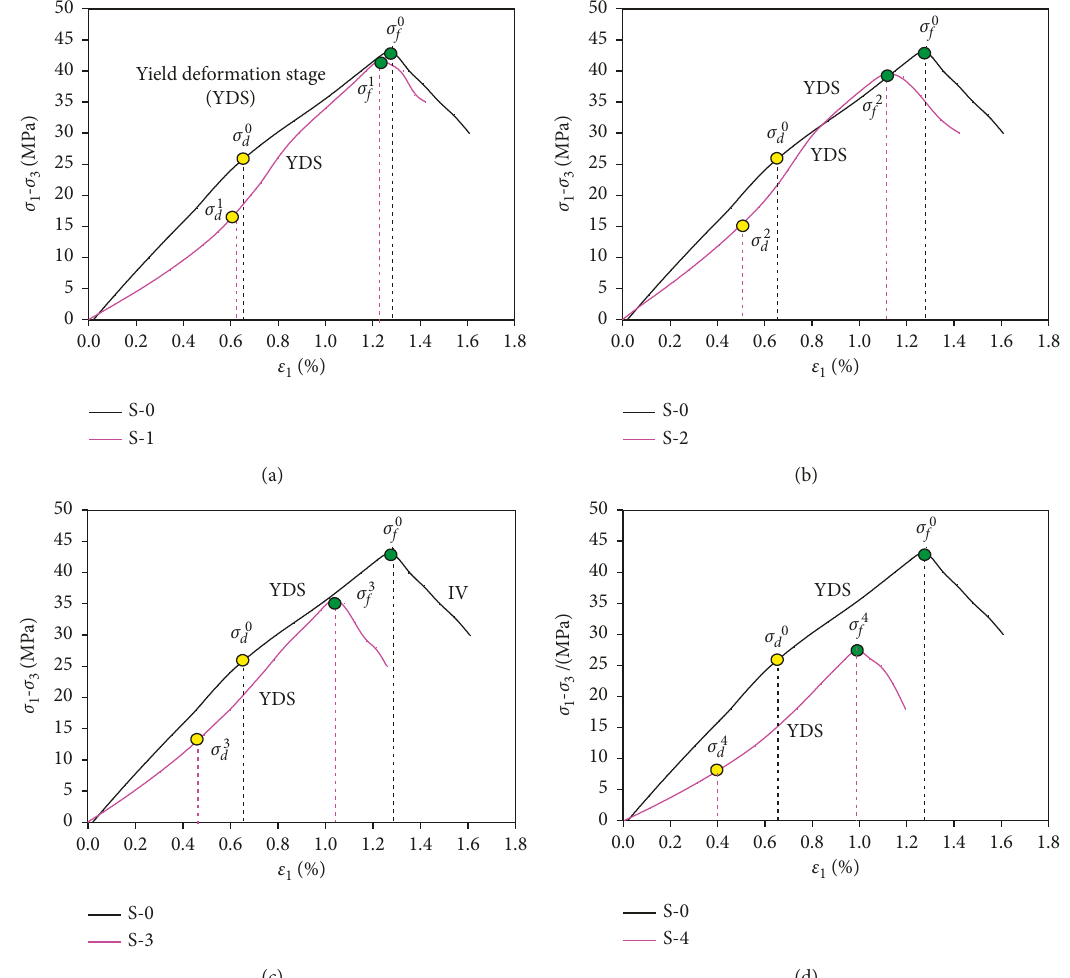
Figure 8: Stress-strain curve comparison of PD rock and intact rock. (a) S-1 rock sample. (b) S-2 rock sample. (c) S-3 rock sample. (d) S-4 rock